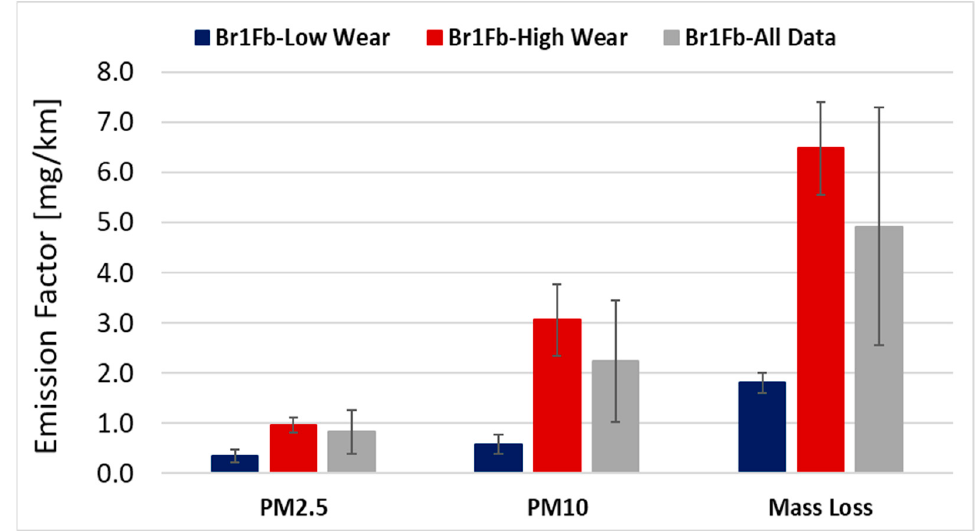
Figure 7. PM and mass loss emissions of Br1Fb. The error bars represent the standard deviation of all measurements.